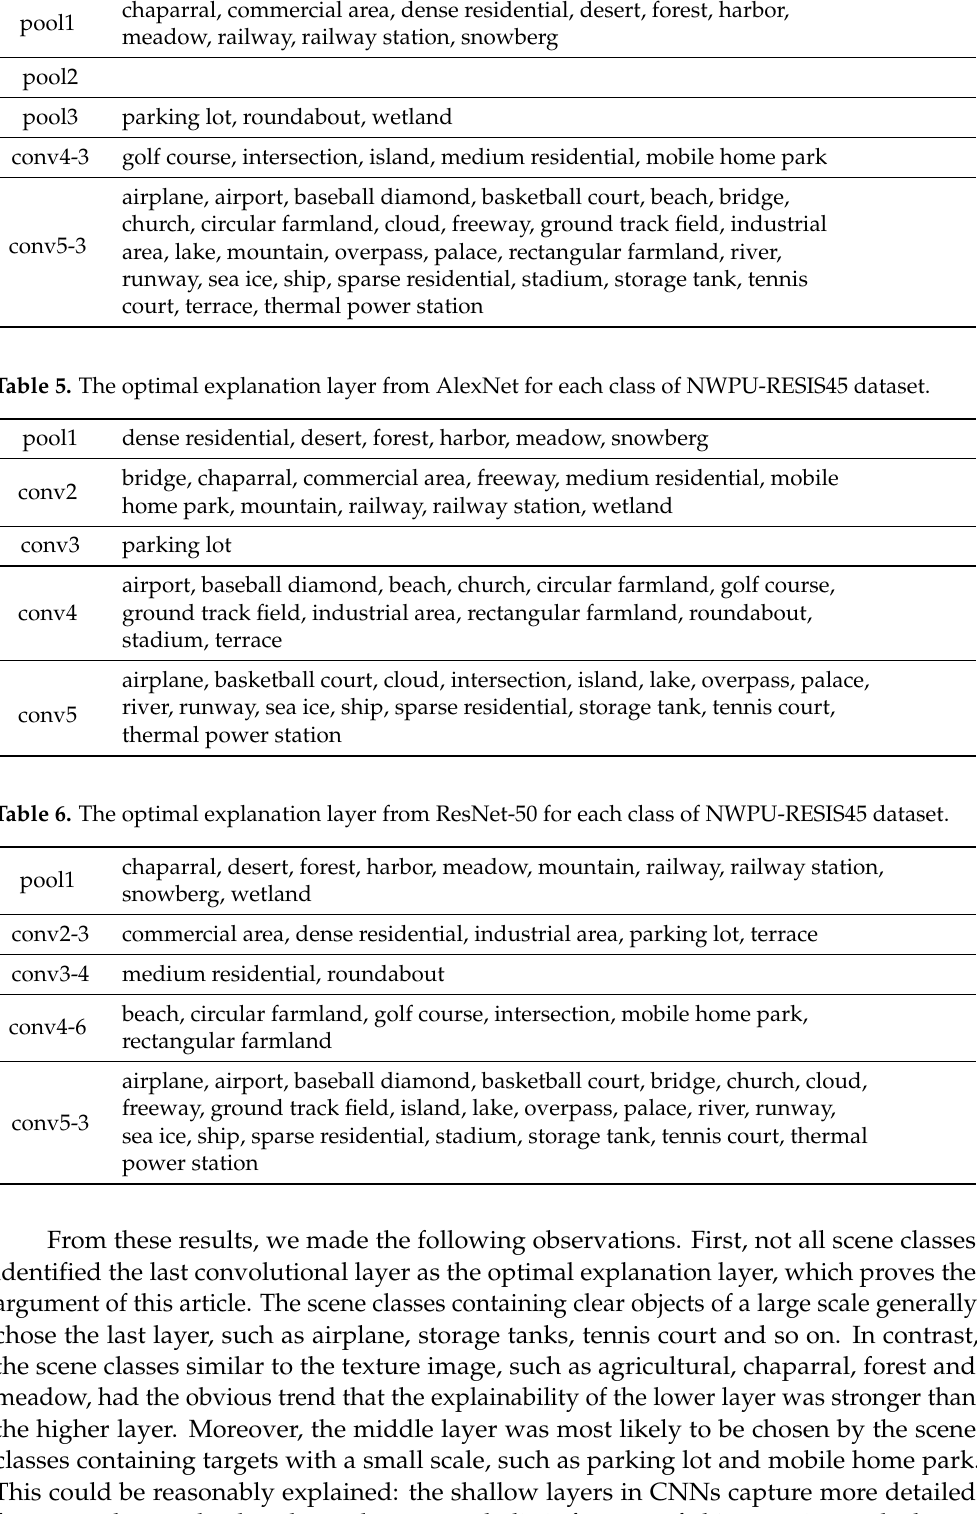
Table 4. The optimal explanation layer from VGG-16 for each class of NWPU-RESIS45 dataset. pool1